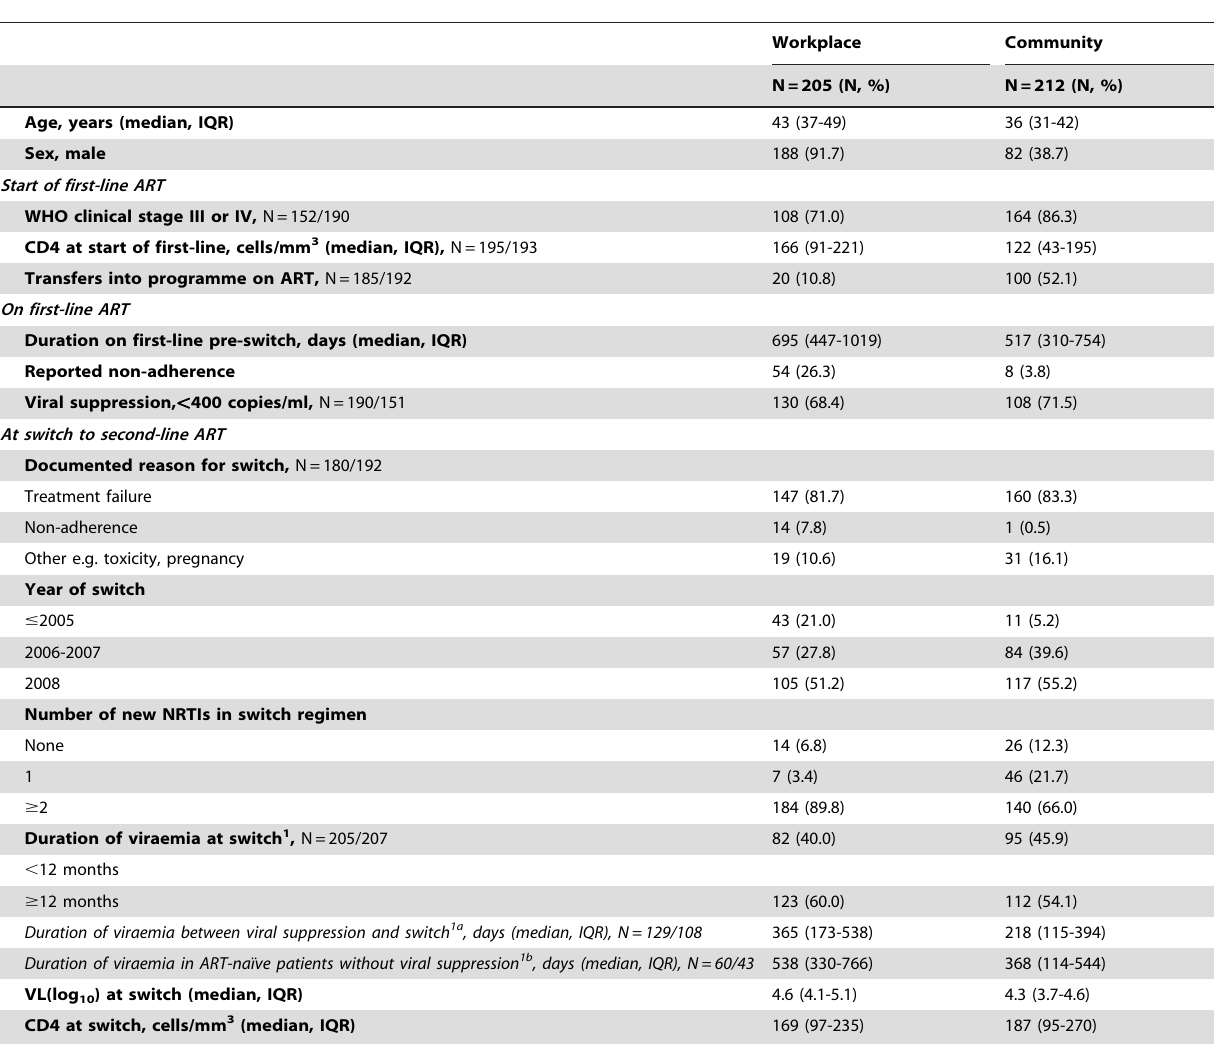
Table 1. Baseline characteristics of patients receiving second-line ART, according to